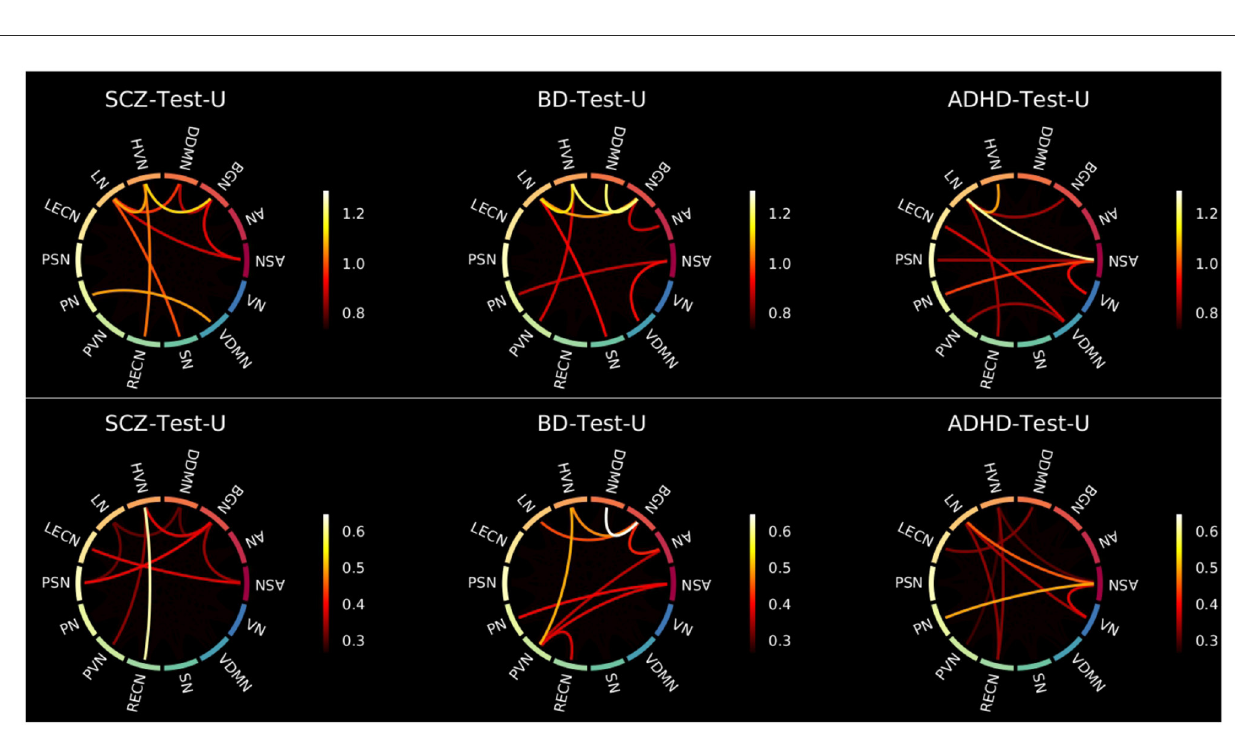
FIGURE5 Connectograms showing the 10 % of pairs of FBNs that were worse reconstructed for each group without (top) and with (bottom) subtraction of the H-Test-U MSE f matrix. The color bar ranges between the lowest and highest values of those 10 % of pairs of FBNs extracted from Figures 3, 4,